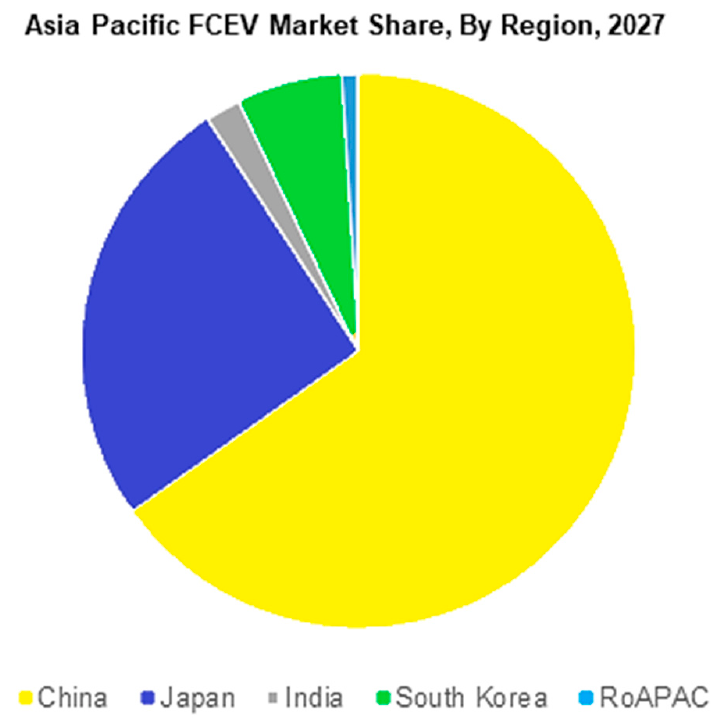
Figure 5. Asia Pacific FCEV market [34]. Figure 5. Asia Paci fi c FCEV market [34].